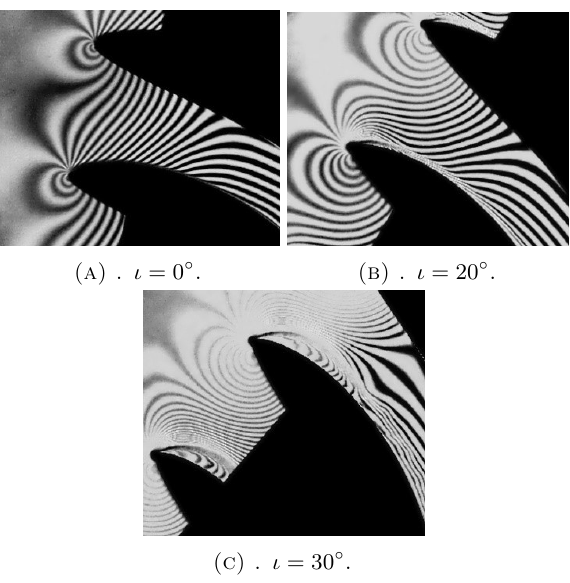
Figure 9. Flow field in the root section cascade at different incidence angles, M 2 is ∼ 1 .